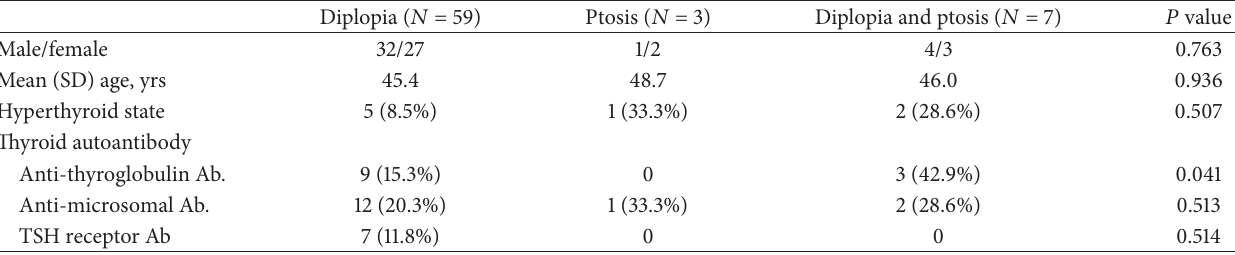
Table 3: Thyroid autoantibodies in three groups.